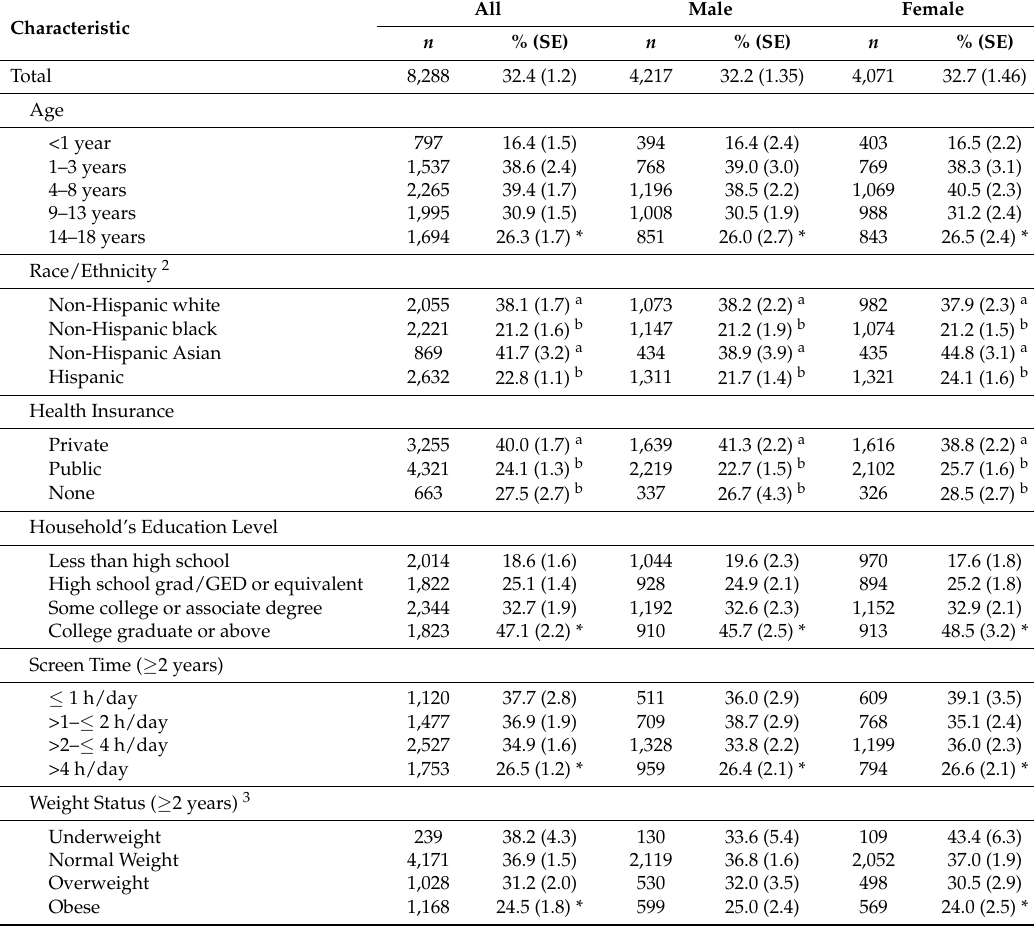
Table 1. Estimated percentage of U.S. children ( ≤ 18 years) who used any dietary supplement in a 30-day period by demographic, lifestyle, and anthropometric characteristics, NHANES 2011–2014 1